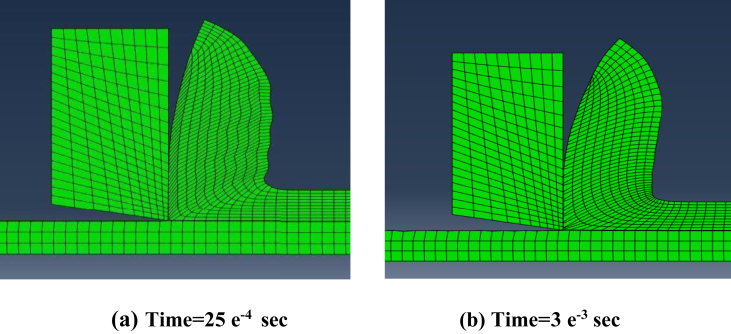
ALE chip morphology.